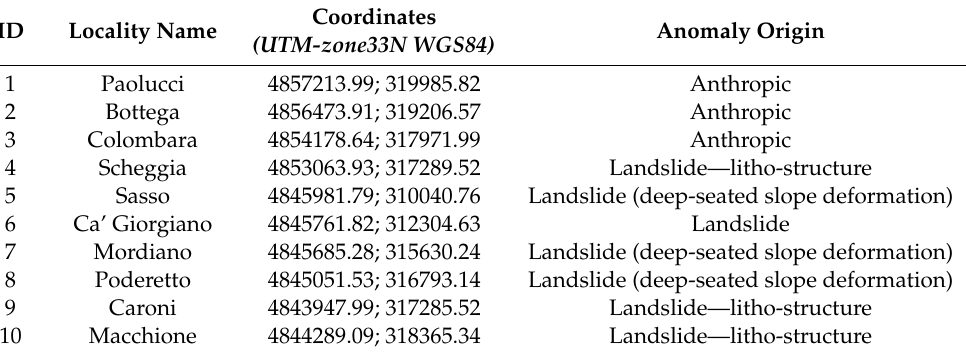
Table 1. SL anomalies occurring within the Apsa River basin, as revealed by SLiX, indicating the principal knickzones occurring along the drainage network. Coordinates and origin of each anomaly have been reported.